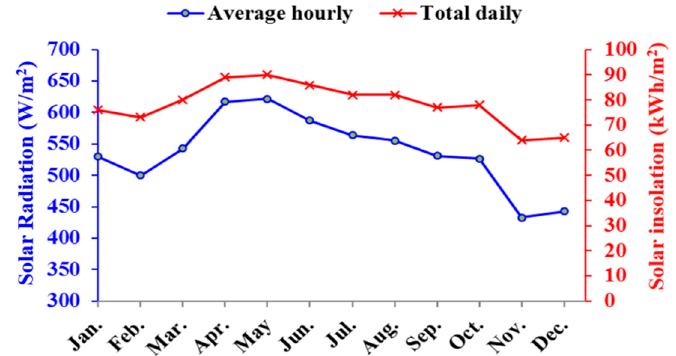
Figure 2. Average hourly and total solar radiation of Al-Ain, UAE for a typical day of each month.